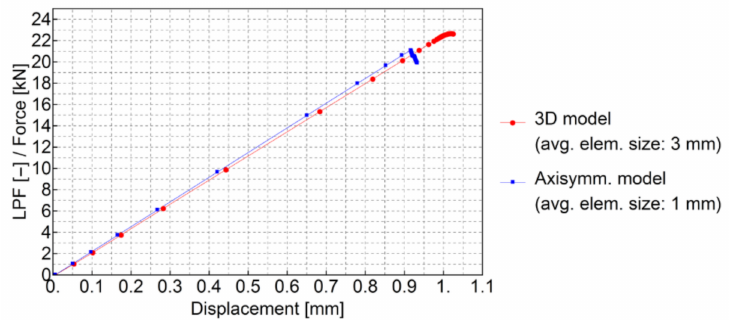
Figure 17. Comparison of force–deflection curves of 3D and axisymmetric models.